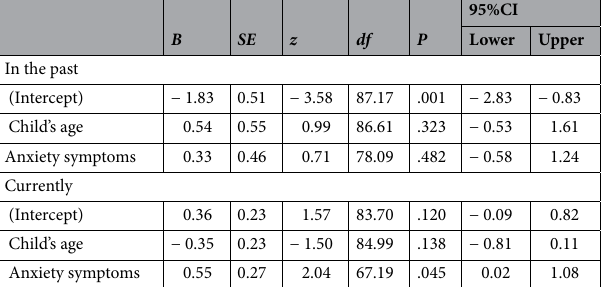
Table 2. Results of the minimum AIC Poisson regression model for sleep aid use. The reference was “did not use sleep aids.” The model was estimated using multiple imputations (see "Methods"